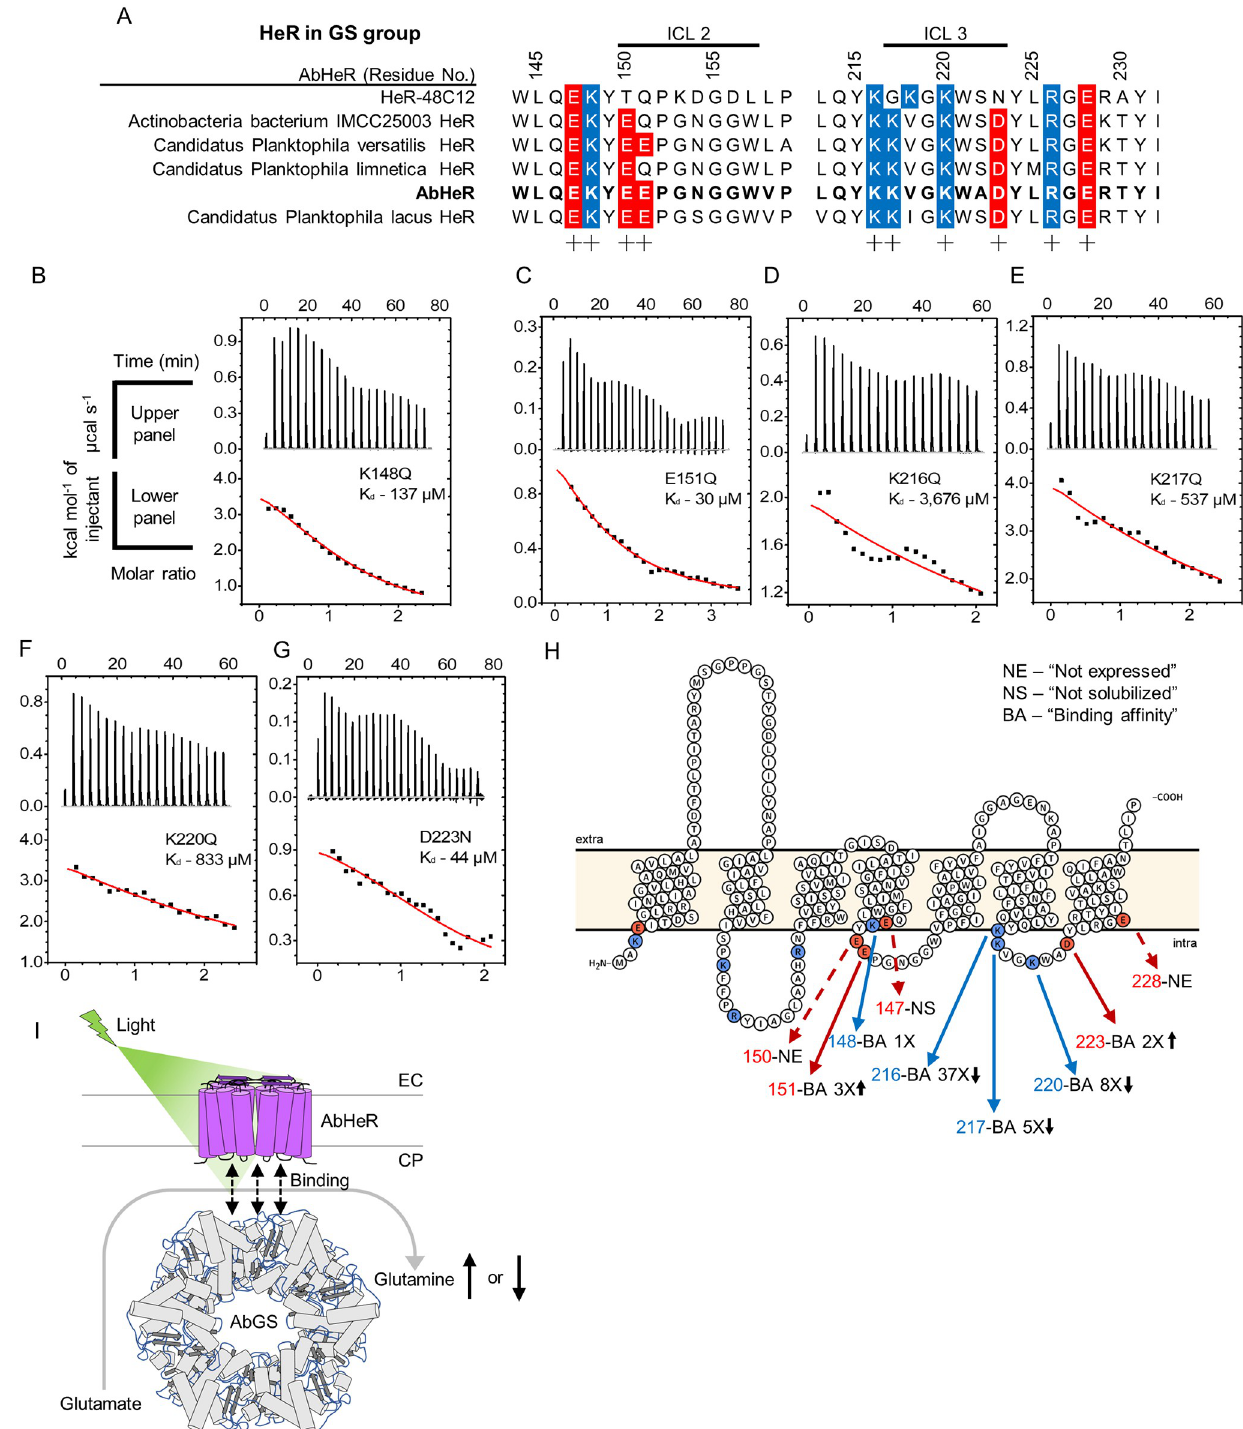
Fig 2. PPIs and binding affinities of AbHeR for AbGS. (A) Multiple sequence alignments of AbHeR and predicted heliorhodopsin in the GS group were aligned using MUSCLE. Alignments of AbHeR with heliorhodopsin in the GS group. Negatively and positively charged residues near intracellular loops of heliorhodopsin are indicated by red and blue, respectively. (B–G) Dissociation constants of AbHeR for AbGS determined using ITC analysis. The upper and lower panels represent raw data and enthalpy change per mol, respectively. AbGS was continuously added to AbHeR mutants. Nonlinear curves of lower panels were evaluated by the best-fit curve. (H) Scheme of PPIs in each amino acid position of AbHeR for AbGS, as predicted by Protter. Positively and negatively charged residues on the cytoplasmic side are indicated as red and blue circles, respectively, with arrows. Dotted arrows indicate not